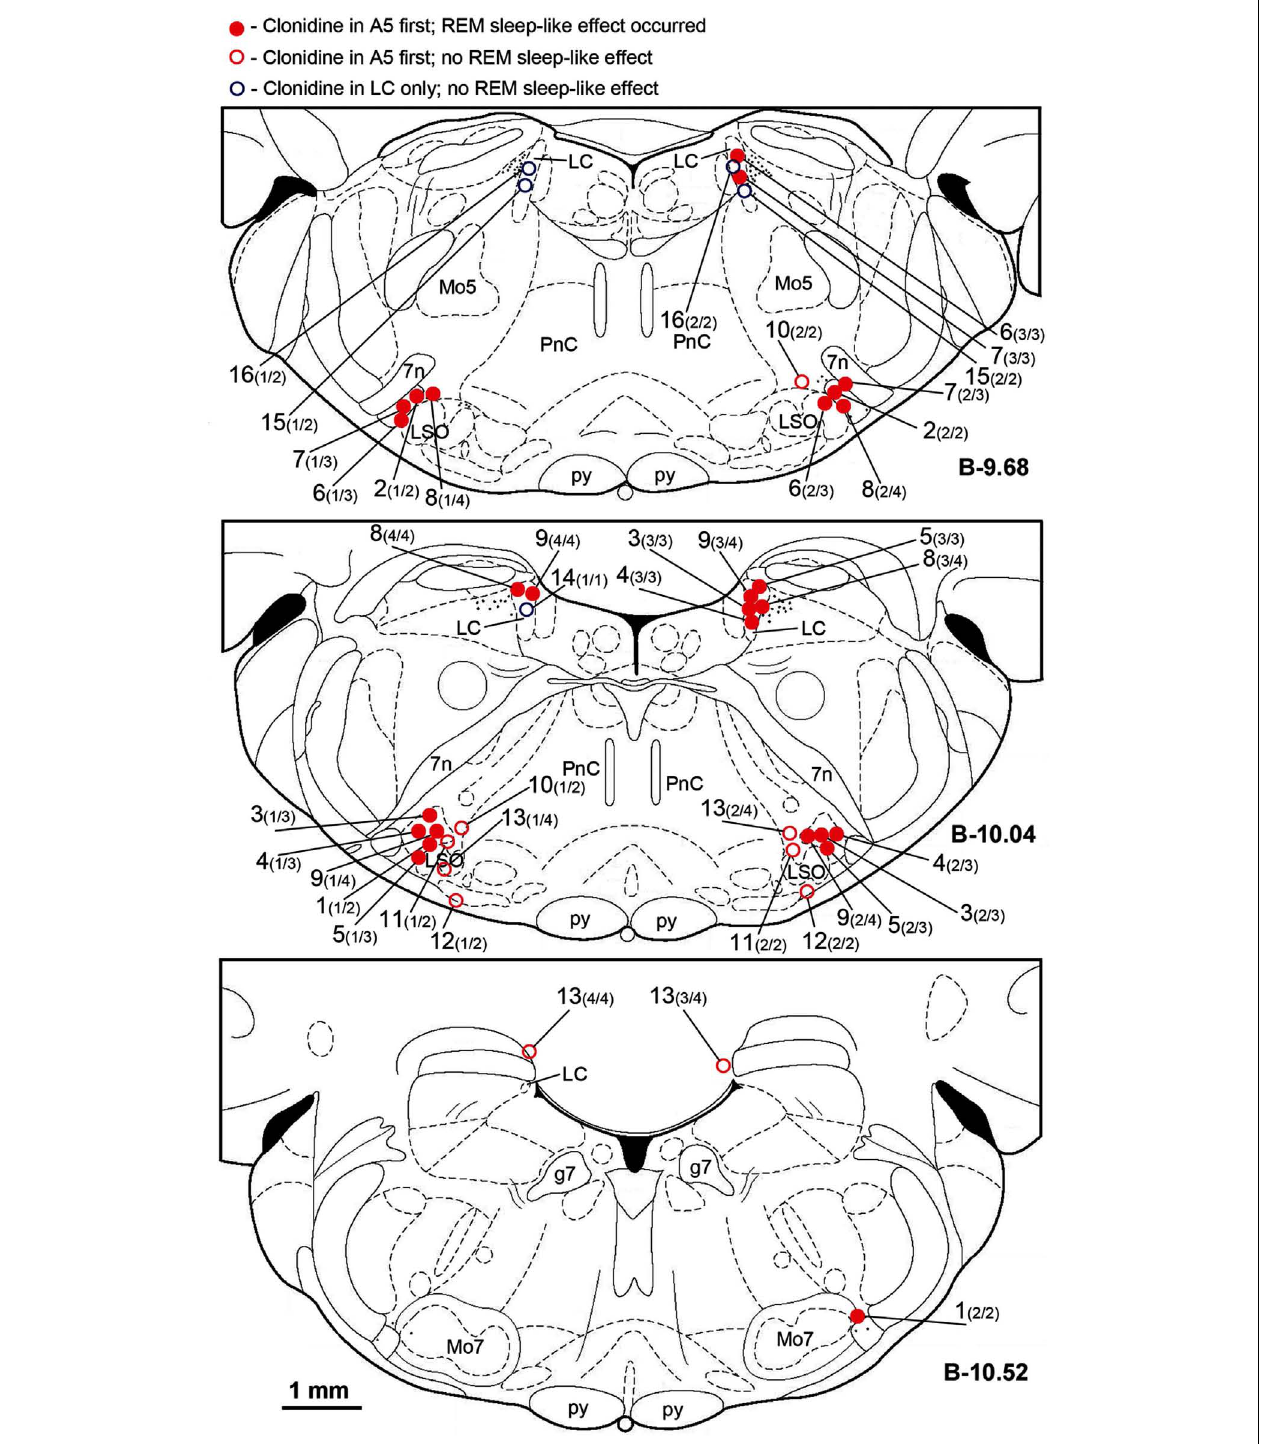
by the experiment (animal) number followed in parenthesis by the sequential order of the injection and the total number of sites injected in this experiment. Red filled and open circles correspond to the experiments in which clonidine was injected first into the A5 regions bilaterally and then, in some animals, also into the locus coeruleus (LC) uni- or bilaterally. Open blue circles